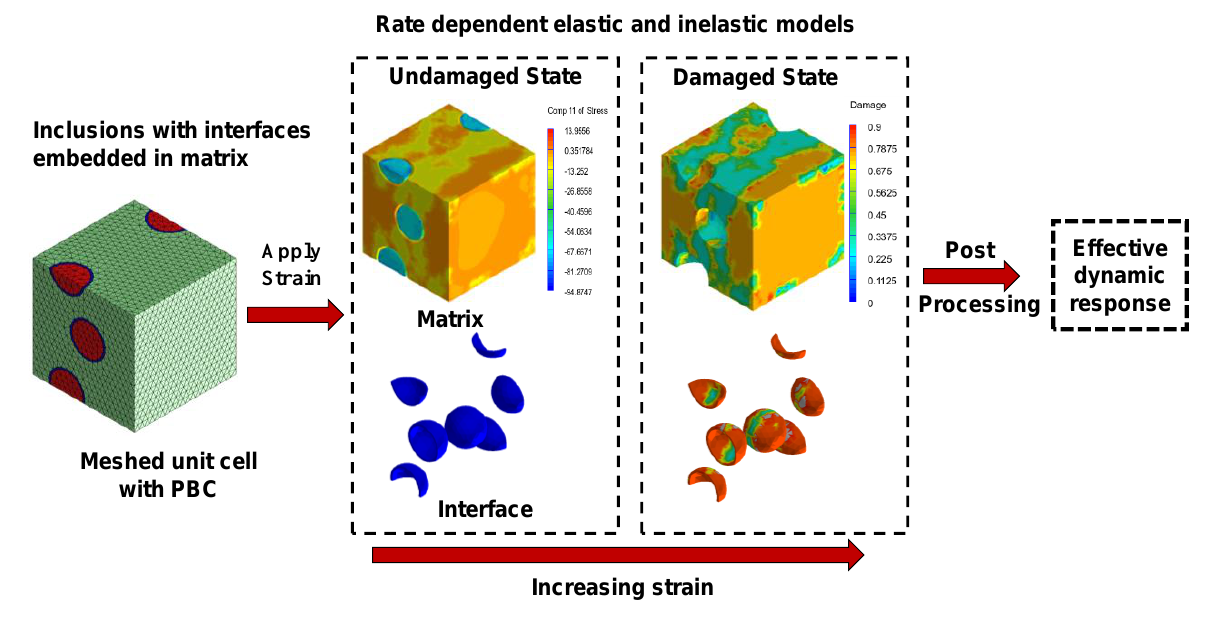
Figure 1. Schematic representation of the homogenization strategy.